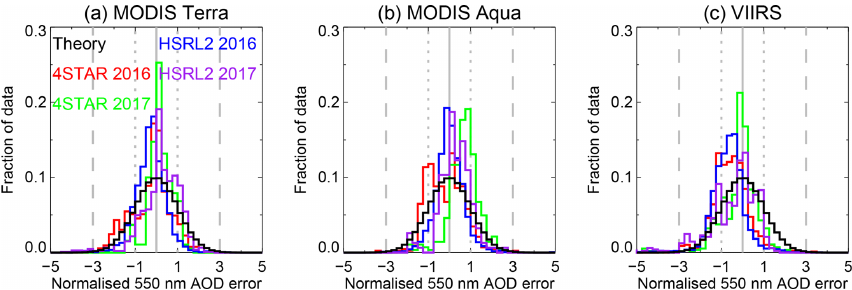
Figure 8. Histograms of normalised retrieval error (i.e. actual error divided by expected difference ED) for AOD at 550nm. Panels show (left–right) data for MODIS Terra, MODIS Aqua, and VIIRS matchups. In all cases matchups from 4STAR 2016, 4STAR 2017, HSRL2 2016, and HSRL2 2017 are shown in red, green, blue, and purple respectively. The black line shows the theoretical Gaussian distribution with mean 0 and variance 1, and dotted and dashed lines indicate ± 1 and ± 3 standard deviations, respectively.